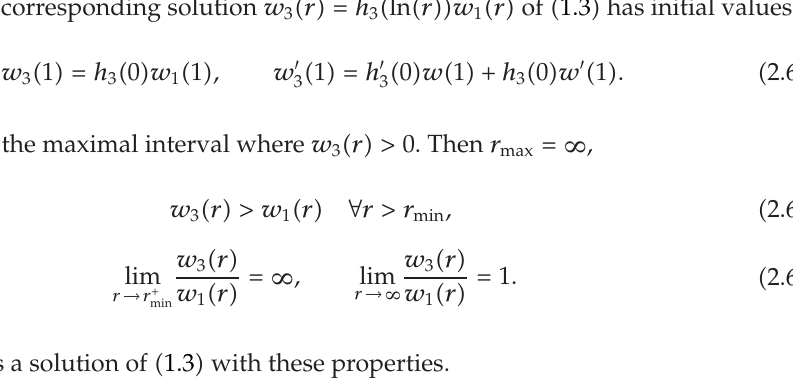
Figure 1 (cid:3) b (cid:4) shows a solution of (cid:3) 1.3 (cid:4) with these